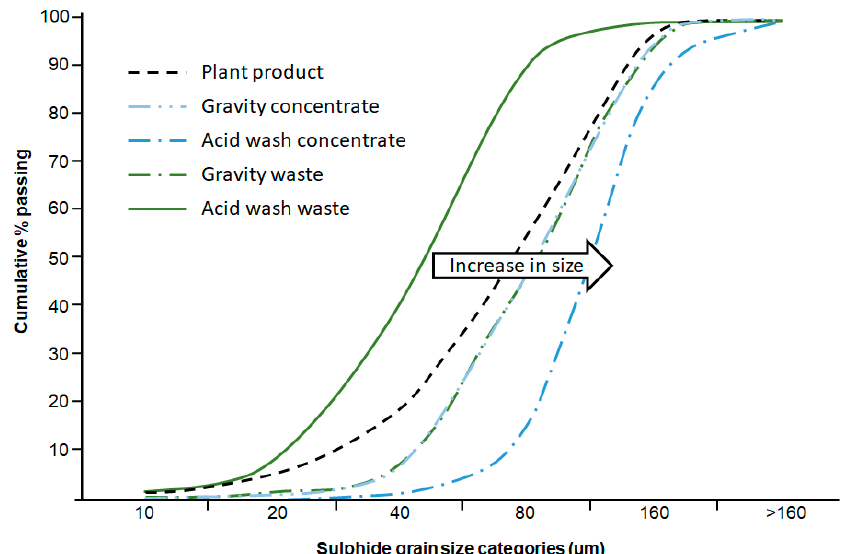
Figure 20. Cumulative sulphide size distribution of the sulphides present in the plant product, gravity concentrate, and acid-wash concentrate. The apparent increase in size is the result of the removal of the finer sulphide sizes.